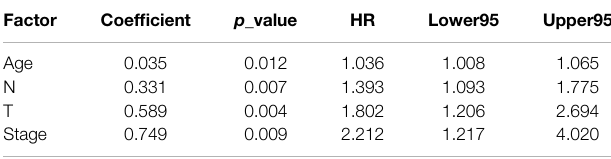
TABLE 2 | Univariate Cox regression results for clinical factors.